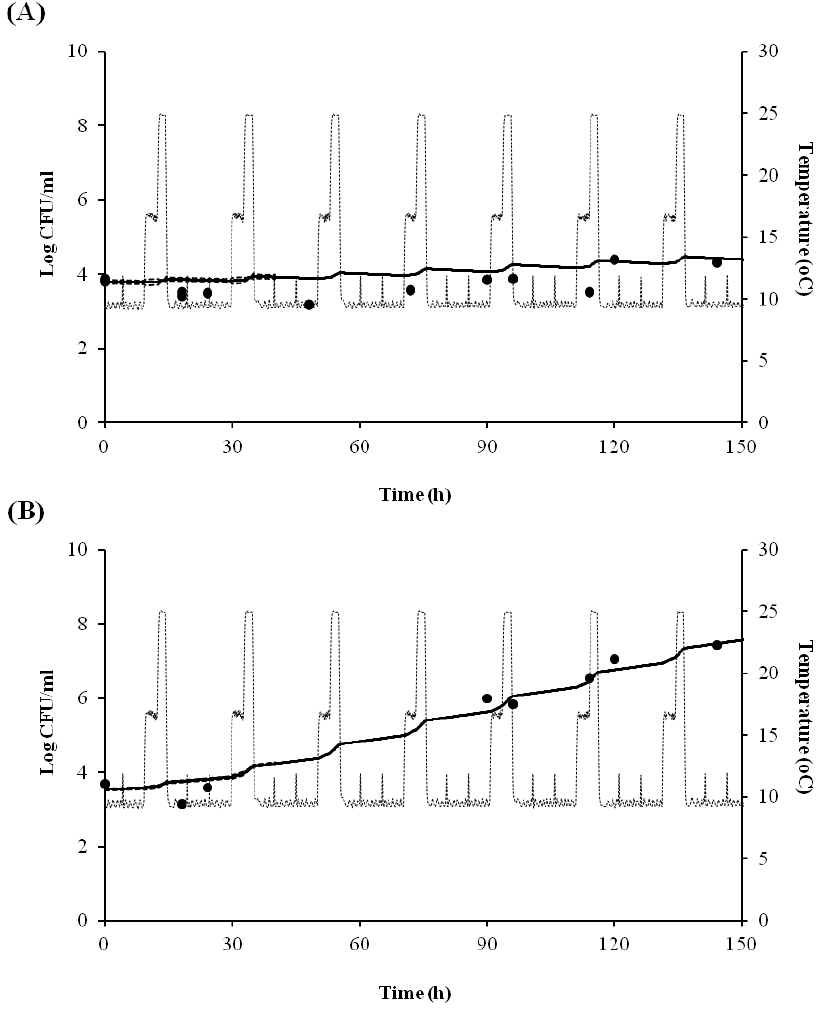
Figure 2. Dynamic model for the Salmonella spp. ( A ) and Staphylococcus aureus ( B ) in the cake during changing temperatures (10–25 °C); symbol: observed value; line: predicted value; dotted line: changing temperatures.